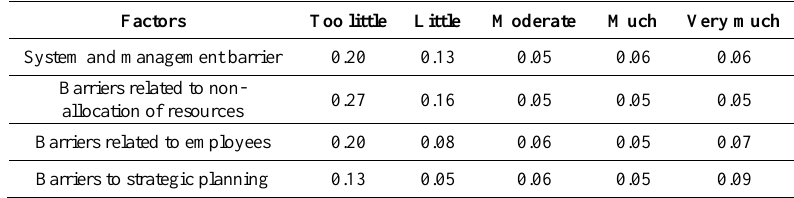
Table 8 . Weighting the non-scale decision